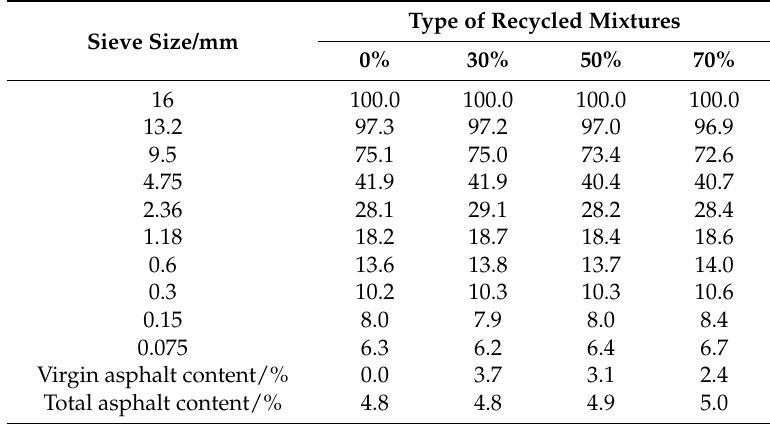
Table 3. Aggregate gradation and asphalt content of recycled mixtures with different reclaimed